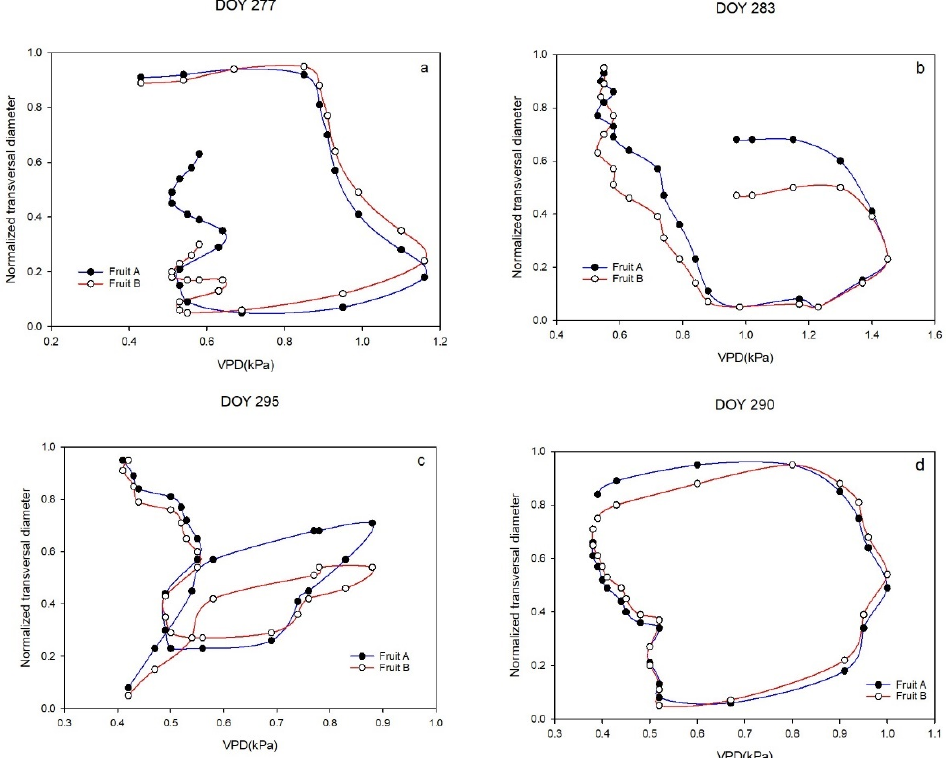
Figure 8. Correlation between transversal diameter and VPD for fruit A and B in four example days of the second period of the experiment: ( a ) incomplete clockwise hysteresis loop; ( b ) hysteresis loop which is near partial clockwise hysteresis loop; ( c ) partial clockwise hysteresis loop; ( d ) incomplete clockwise hysteresis loop for fruit A and complete clockwise hysteresis for fruit B.